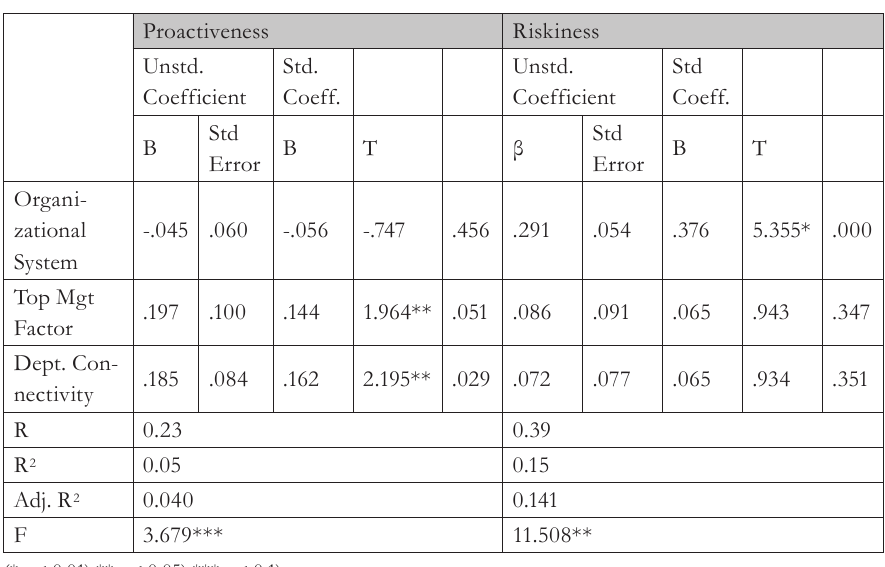
Tab. 6 - Impact of Organizational System, Top Management Factor, and Departmental Connec- tivity on Proactiveness and Riskiness Dimensions. Source: Field